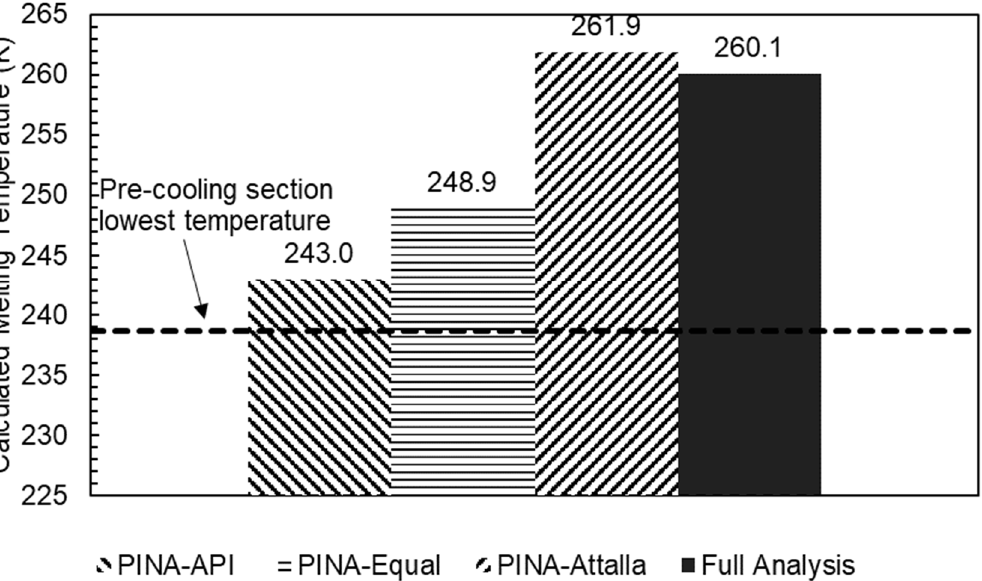
Figure 5. Comparison of the melting temperatures calculated using various PINA freeze-out pre- diction methods at a pressure of 6.307 MPa (900 psig) with that based on the full compositional characterization for the rich gas sample.